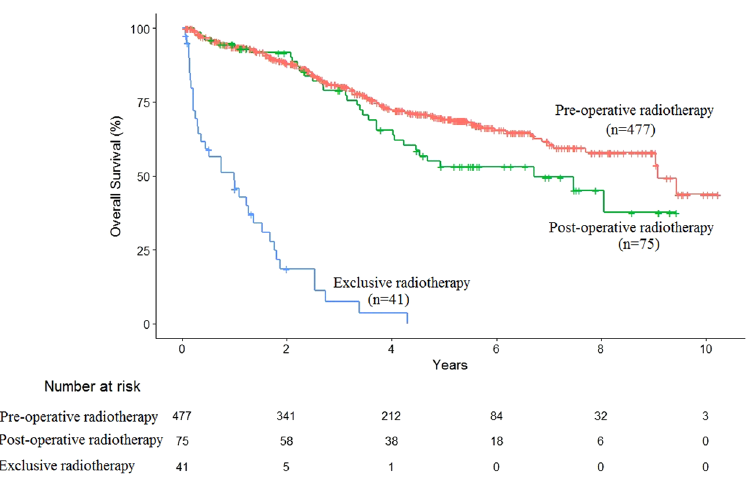
Figure 1. Overall survival of patients experiencing pre-operative, post-operative or exclusive